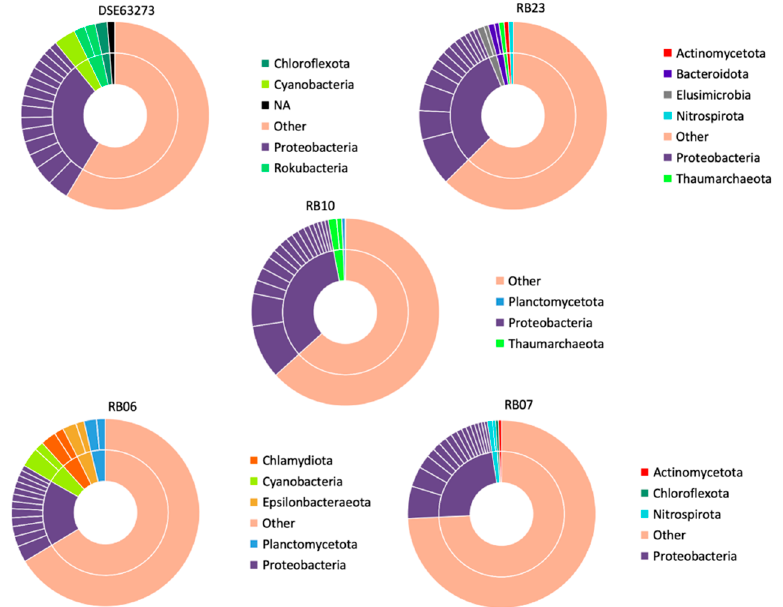
Figure 2. Sunburst chart of 20 microorganisms (OTUs) with the highest abundance in the nitrate- contaminated bores (NCBs) (DSE63273, RB23, RB10, RB06, RB07) separated by bore and organised by phylum. ‘Other’ represents the proportion of OTUs not represented by the 20 most abundant OTUs. The inner ring of the sunburst chart represents the phylum taxonomic level and the inner ring represents the individual OTUs.